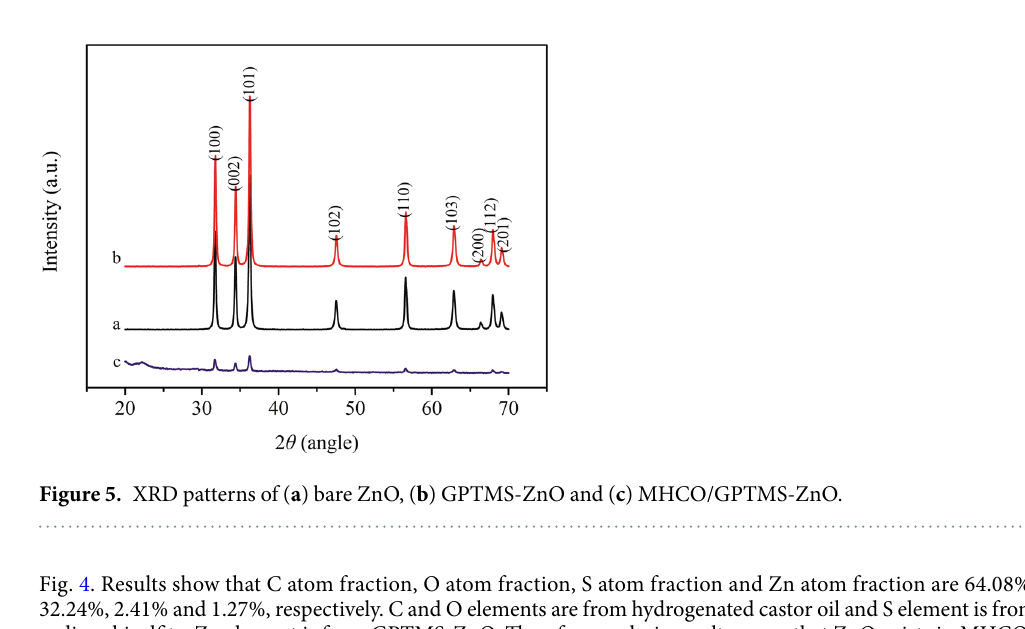
Fig. 4. Results show that C atom fraction, O atom fraction, S atom fraction and Zn atom fraction are 64.08%, 32.24%, 2.41% and 1.27%, respectively. C and O elements are from hydrogenated castor oil and S element is from sodium bisulfite. Zn element is from GPTMS-ZnO. Therefore analysis result proves that ZnO exists in MHCO/ GPTMS-ZnO composites. The GPTMS-ZnO and bare ZnO are used as blank control to prove the existence of GPTMS-ZnO in MHCO/ GPTMS-ZnO composites. Figure 5 shows the XRD patterns of (a) bare ZnO, (b) GPTMS-ZnO and (c) MHCO/ GPTMS-ZnO. From Fig. 5a, a series of characteristic peaks at 2 θ = 31.9° (100), 33.3° (002), 36.4° (101), 47.7° (102) and 56.7° (110) are observed and they are in accordance with the zincite phase of ZnO. Figure 5b illustrates that after modification, the characteristics peaks position of ZnO remained invariant and is in accordance with the zincite phase of ZnO. This indicates that the grafted silane group doesn’t influence the crystalline structure 8 . The XRD pattern of MHCO/GPTMS-ZnO composites (Fig. 5c) contains the peaks of ZnO, whereas the peak intensities are relatively lower in comparison with those of pure ZnO. The results indicate that ZnO exists in MHCO/GPTMS-ZnO composites and the crystallinity ZnO decreases because of low content of ZnO in MHCO/ GPTMS- ZnO composites. Particle size distribution of fatliquoring agent emulsion is an important index of fatliquoring agent, which has an influence on fatliquoring agent penetration into leather structure 16 . The morphology and structure of MHCO/ GPTMS-ZnO composites emulsion were observed by the TEM and DLS results as shown in Fig. 6 and Fig. 7. TEM in Fig. 6 shows that MHCO/GPTMS-ZnO composites emulsion is composed of spherical particles with diameters of 50~300 nm and GPTMS-ZnO nanoparticles are impregnated in MHCO. This is because MHCO having amphiphilic groups plays a role of the surfactant, which can wrap the hydrophobic GTPMS-ZnO nan- oparticles and unreacted HCO, forming the spherical latex particles. The results from DLS in Fig. 7 reveal that MHCO/GPTMS-ZnO composites have narrow size distribution, uniform morphology, and an average diameter of 291.6 nm, which is consistent with those observed from TEM image. On the basis of all of the above FT-IR spectra, XRD patterns, DLS and TEM observations, it can be seen that MHCO/GPTMS-ZnO composites have been obtained by the present method.